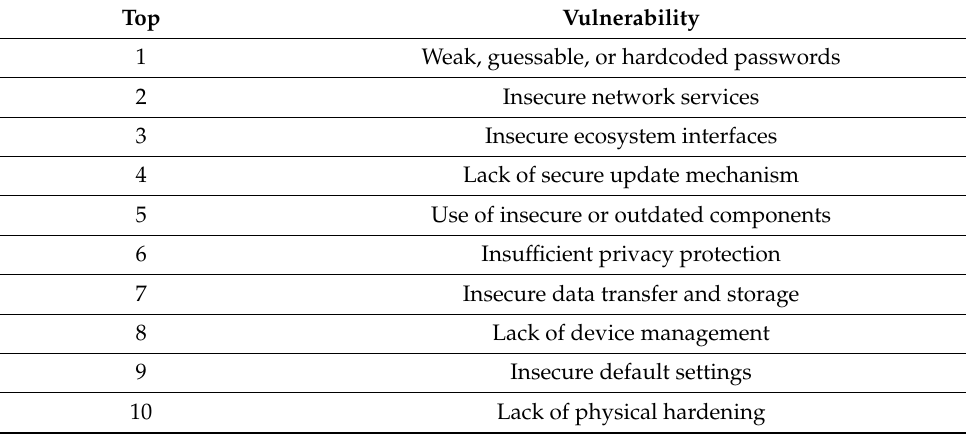
Table 5. Top ten attacks in IoT systems.